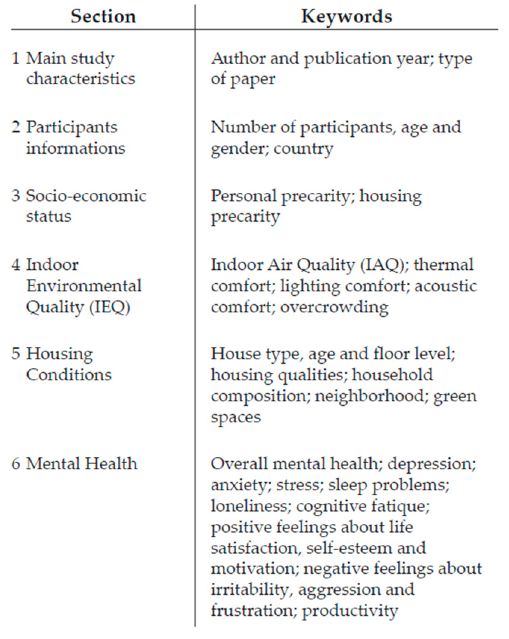
Figure 5. Clusterization of sections.